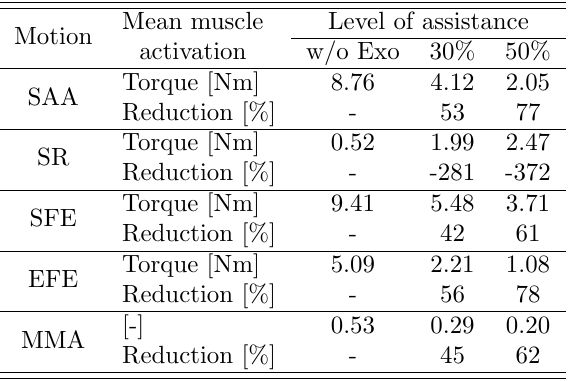
For the elbow joint, the reduction of the mean reaction force is 53% and 52% for the low- and high-level assis- tance, respectively, as listed in Table